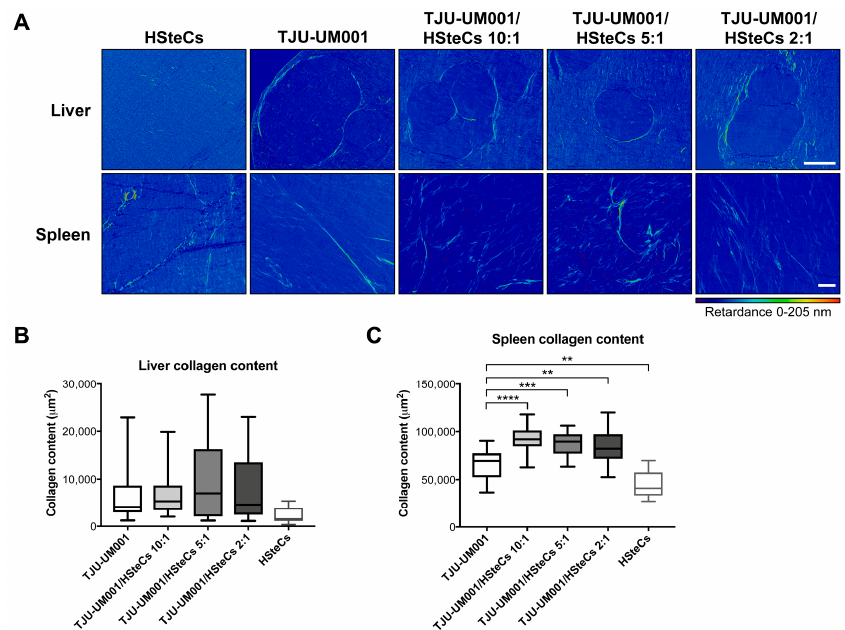
Figure 5. Human HSteCs accumulate fibrillar collagen when co-injected with metastatic UM cells. ( A ) QPOL imaging of the liver (top panels) and spleen (bottom panels) of triple-immunodeficient mice ( N = 4 per condition) bearing UM metastases generated with the TJU-UM001 cell line inoculated alone or in combination with human HSteCs (ratios 10:1, 5:1 or 2:1). The dark blue to red signal corresponds to the collagen content (retardance scale) at 6 weeks post-inoculation. Scale bars, 100 µ m. The collagen content in the liver ( B ) or spleen ( C ) expressed in µ m 2 for the five groups is represented as box-and-whisker plots, with the median indicated by the horizontal line. One-way ANOVA with Dunnett’s post hoc test, ** p < 0.01, *** p < 0.001 and **** p <